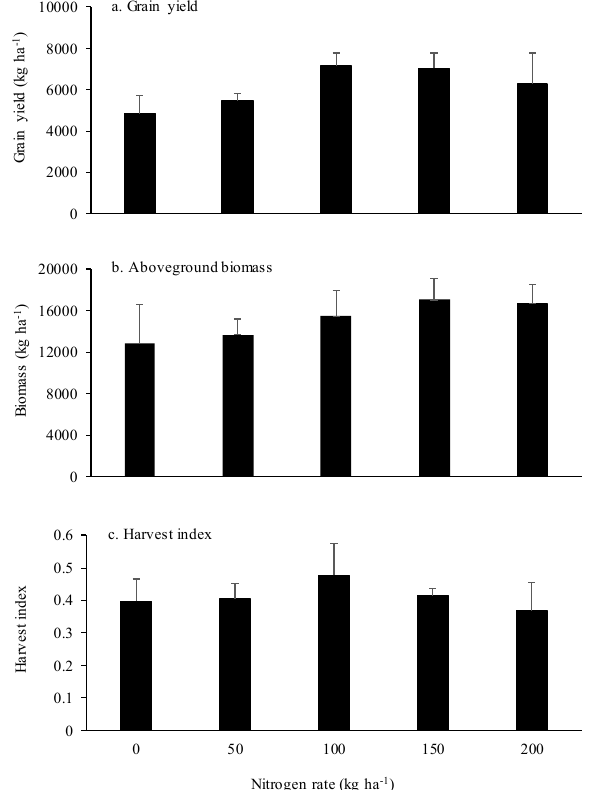
Figure 1. Rice grain yield ( a ), aboveground biomass ( b ) and harvest index ( c ) response to nitrogen fertiliser rate on an acidic Gleysol. Error bars depict SEM ( n = 3).